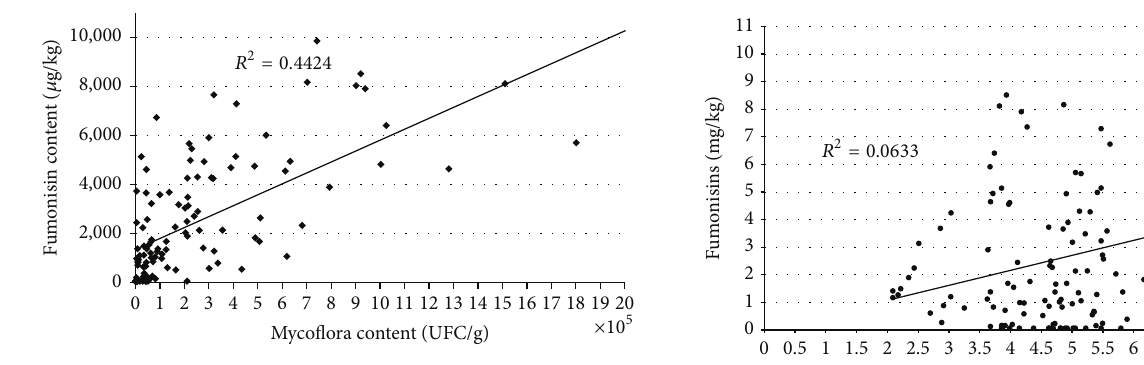
Figure 2: Relationship between fungal count and fumonisins contamination based on 117 samples of maize.